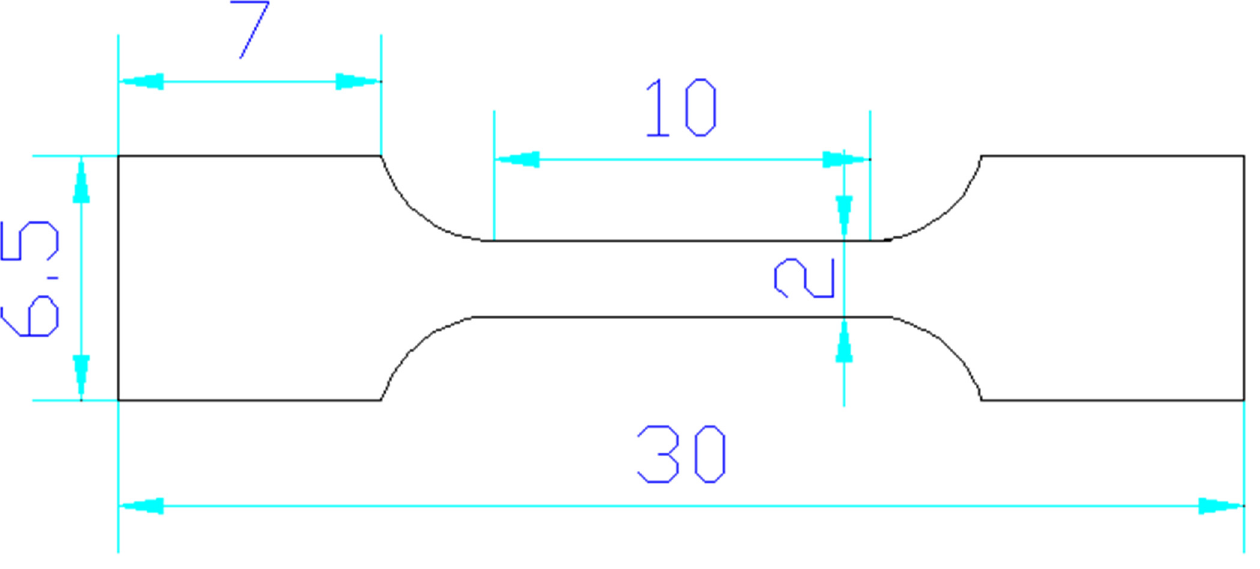
Figure 3. The illustration of tensile specimen size